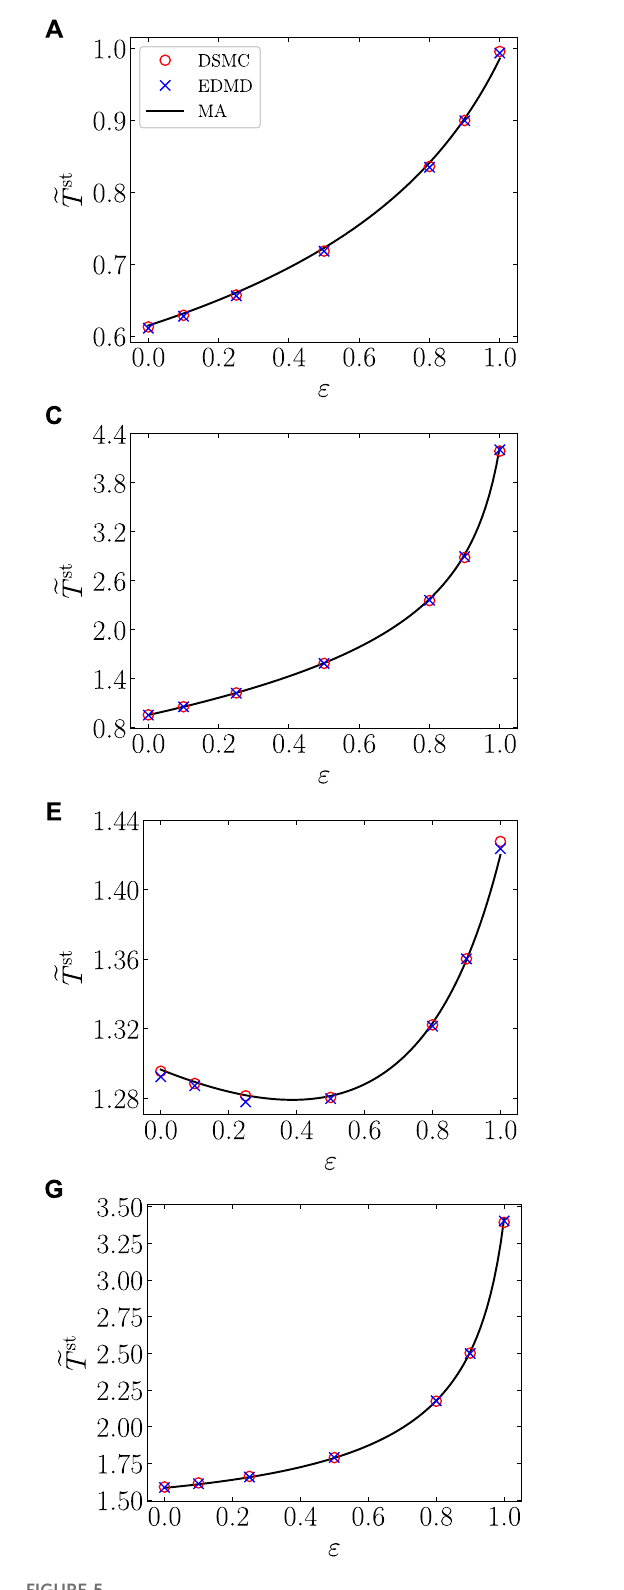
FIGURE 5 Steady-state values of the mean temperature ~ T st and the rotational-to-translational temperature ratio θ st as functions of ε . The values of the coef fi cientsofrestitutionare (A,B) :( α , β )=(0.7,0); (C,D) :( α , β )=(0.7, − 0.7); (E,F) :( α , β )=(0.9,0);and (G,H) :( α , β )=(0.9, − 0.7).Thickblacklinescorrespond to the theoretical prediction in Eqs. 26, and symbols refer to DSMC (o) and EDMD (×) simulation results for ε = 0, 0.1, 0.25, 0.5, 0.8, 0.9, and